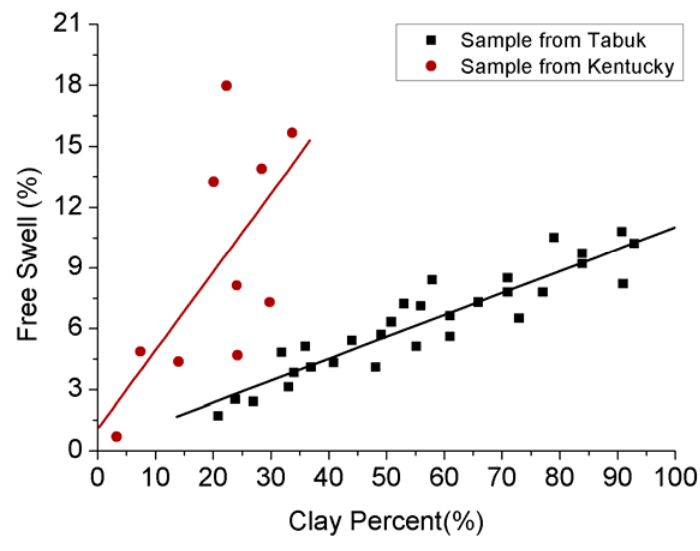
Figure 3. Relationship between swelling effect and clay content [60,61].